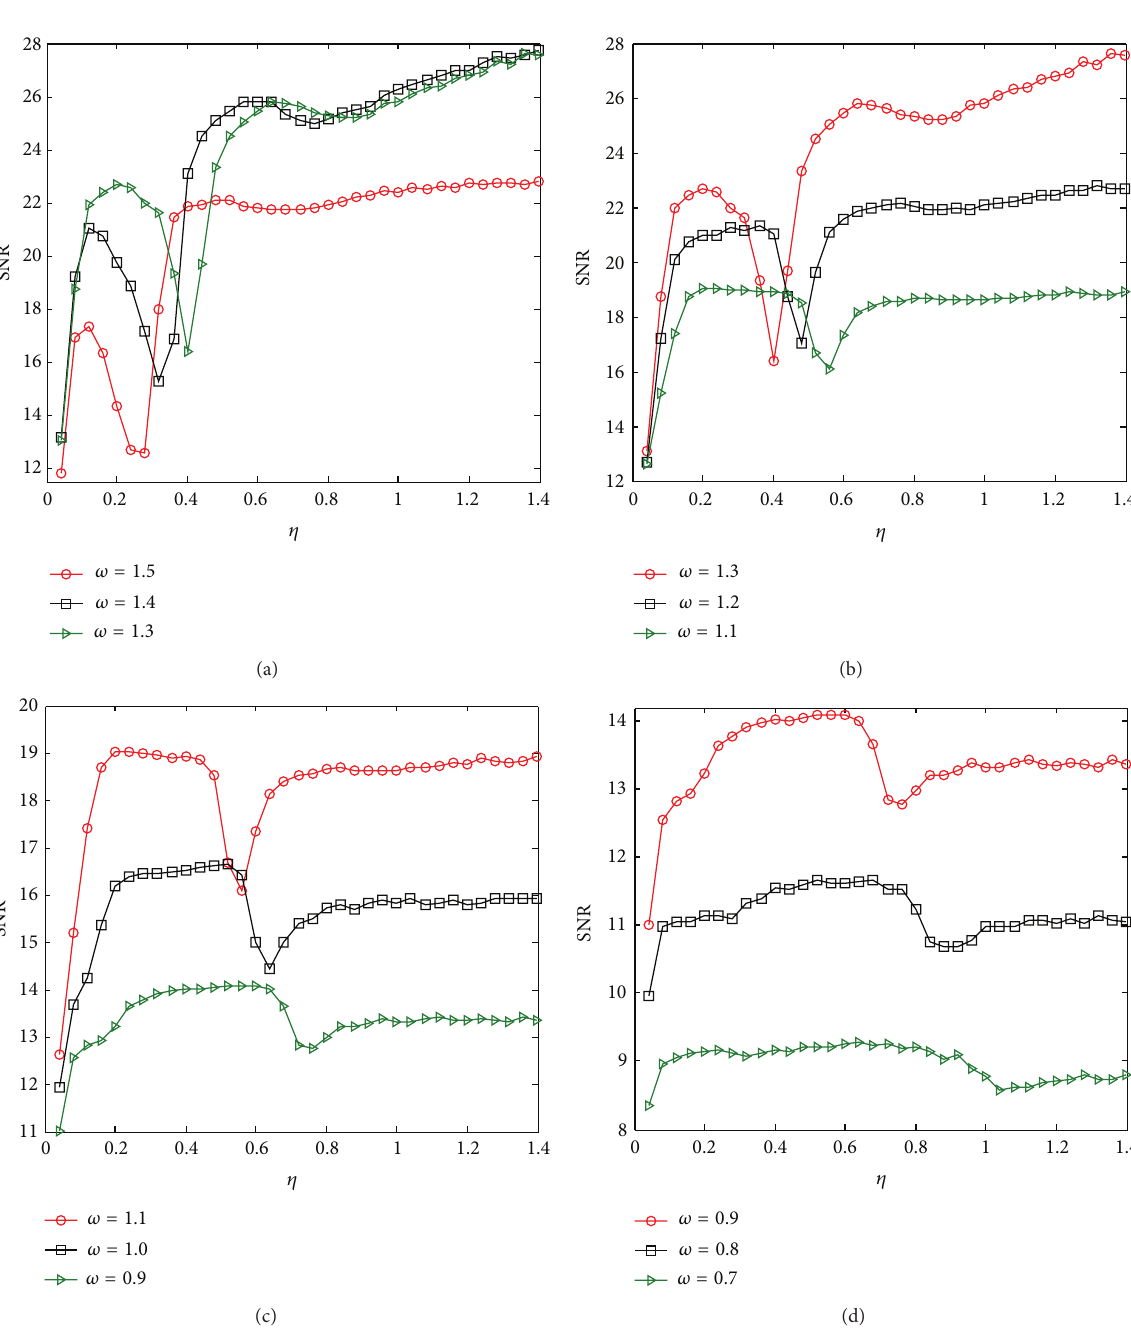
Figure 5: SNR versus the damping coefficient for the different forcing frequencies of the periodic